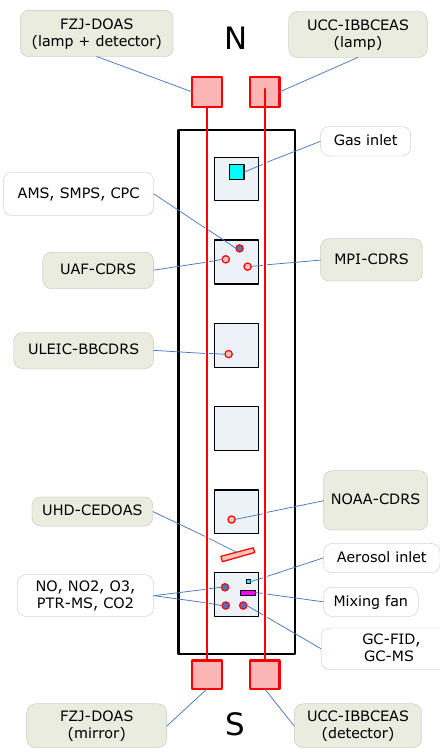
Fig. 1. Schematic top view onto the floor of SAPHIR with the posi- tions of the individual instruments and inlet lines. The red lines indi- cate the open light paths of the FZJ-DOAS and UCC-IBBCEAS in- struments, respectively. The UHD-CEDOAS open-path instrument was assembled on the floor of the chamber. All other NO 3 instru- ments drew air from flanges in the chamber floor at the designated